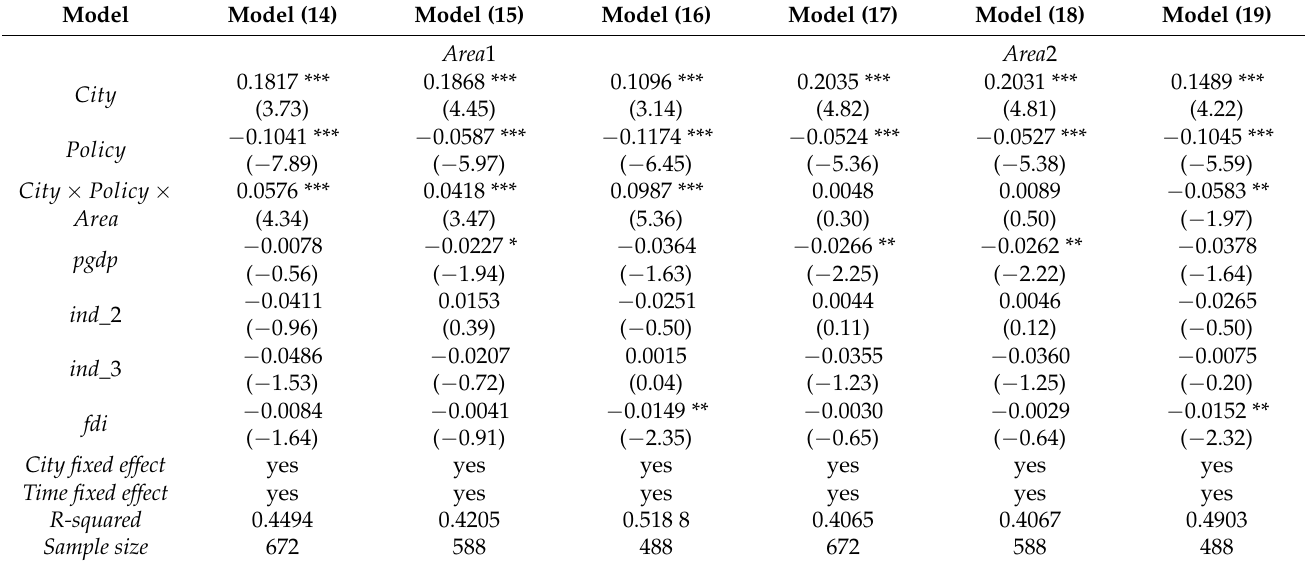
Table 5. Cross-regional heterogeneity test of low-carbon pilot policy promoting urban green